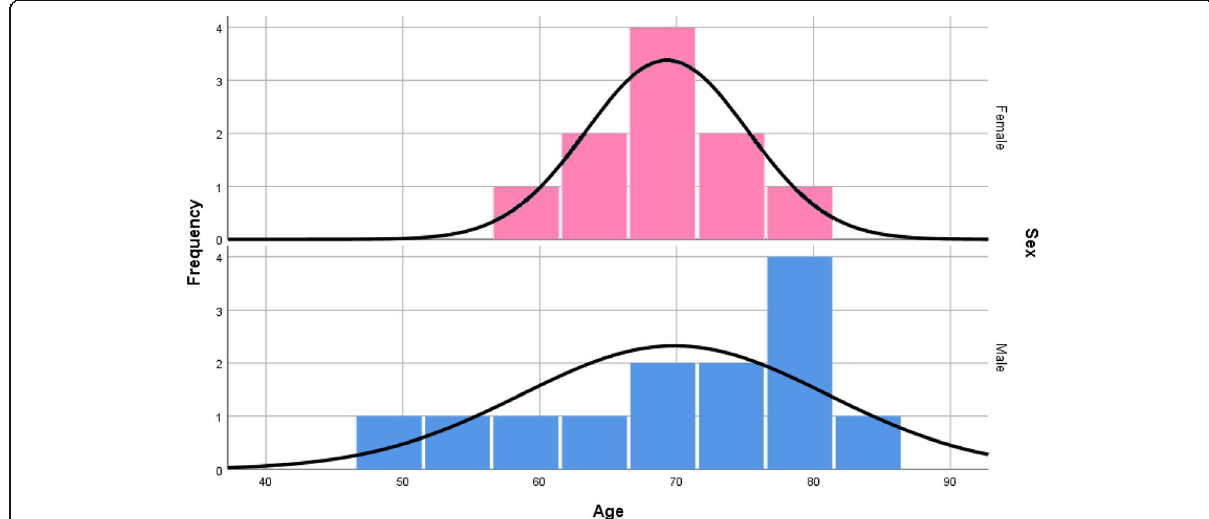
Fig. 4 Distribution of frequency by age in female and male patients with exemplary normal distribution